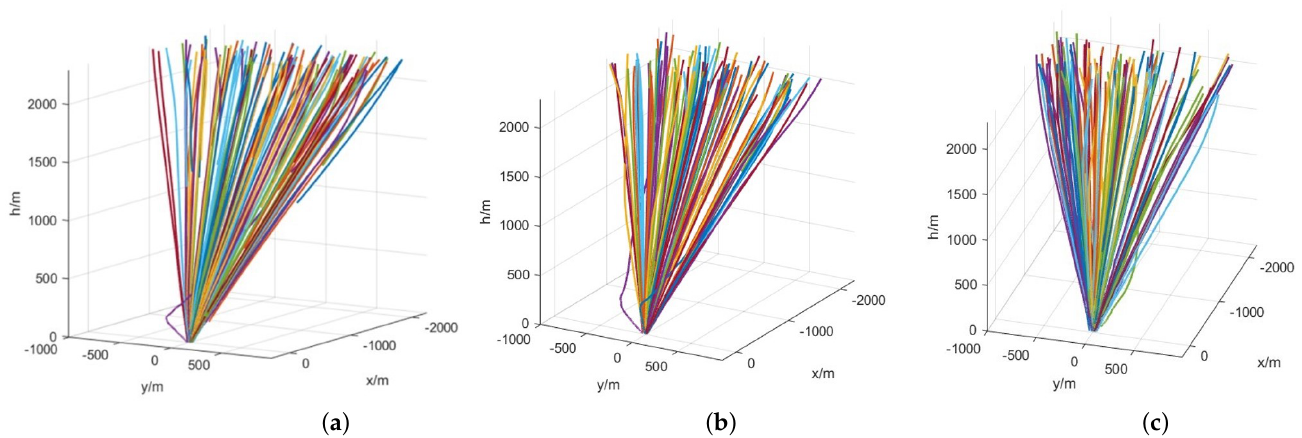
Figure 7. Landing trajectories of lander under the control of the trained velocity controller. ( a ) DDPG. ( b ) TD3. ( c ) SAC.